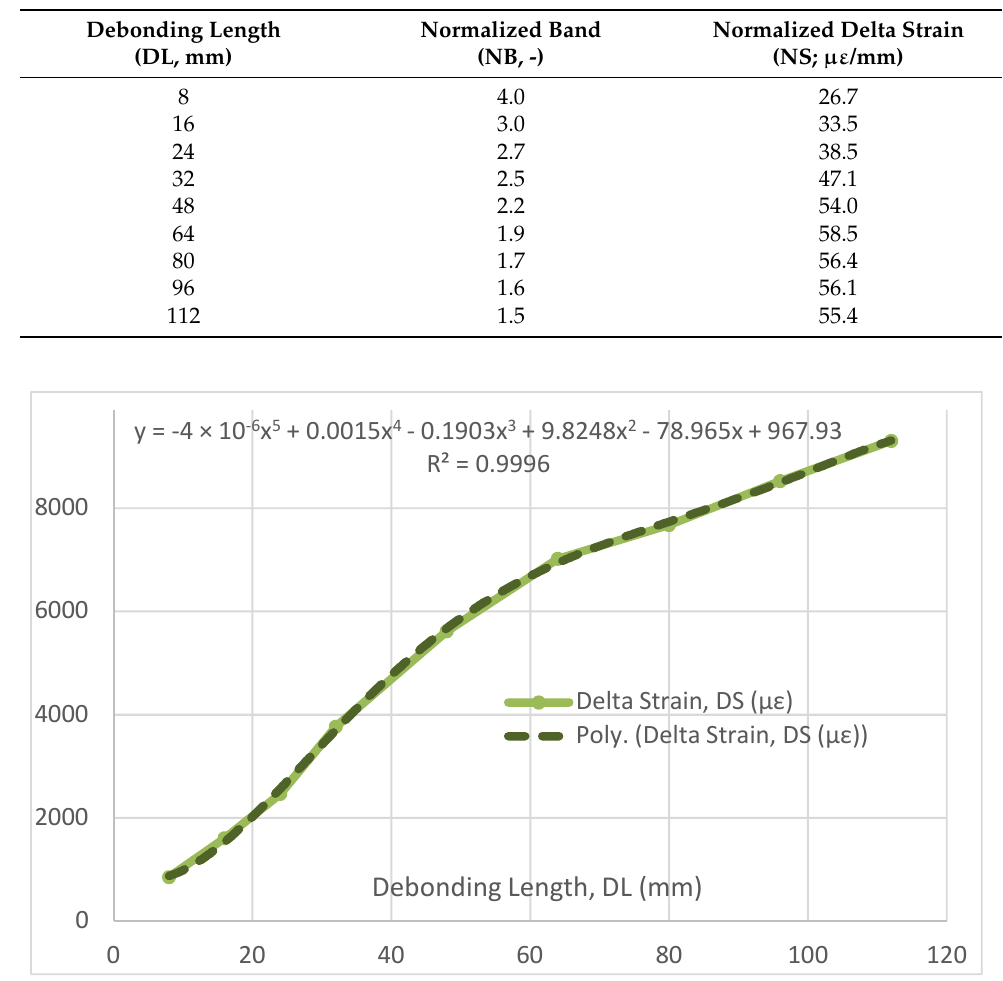
Figure 14. Delta strain as a function of the debonding length, and its polynomial approximation.